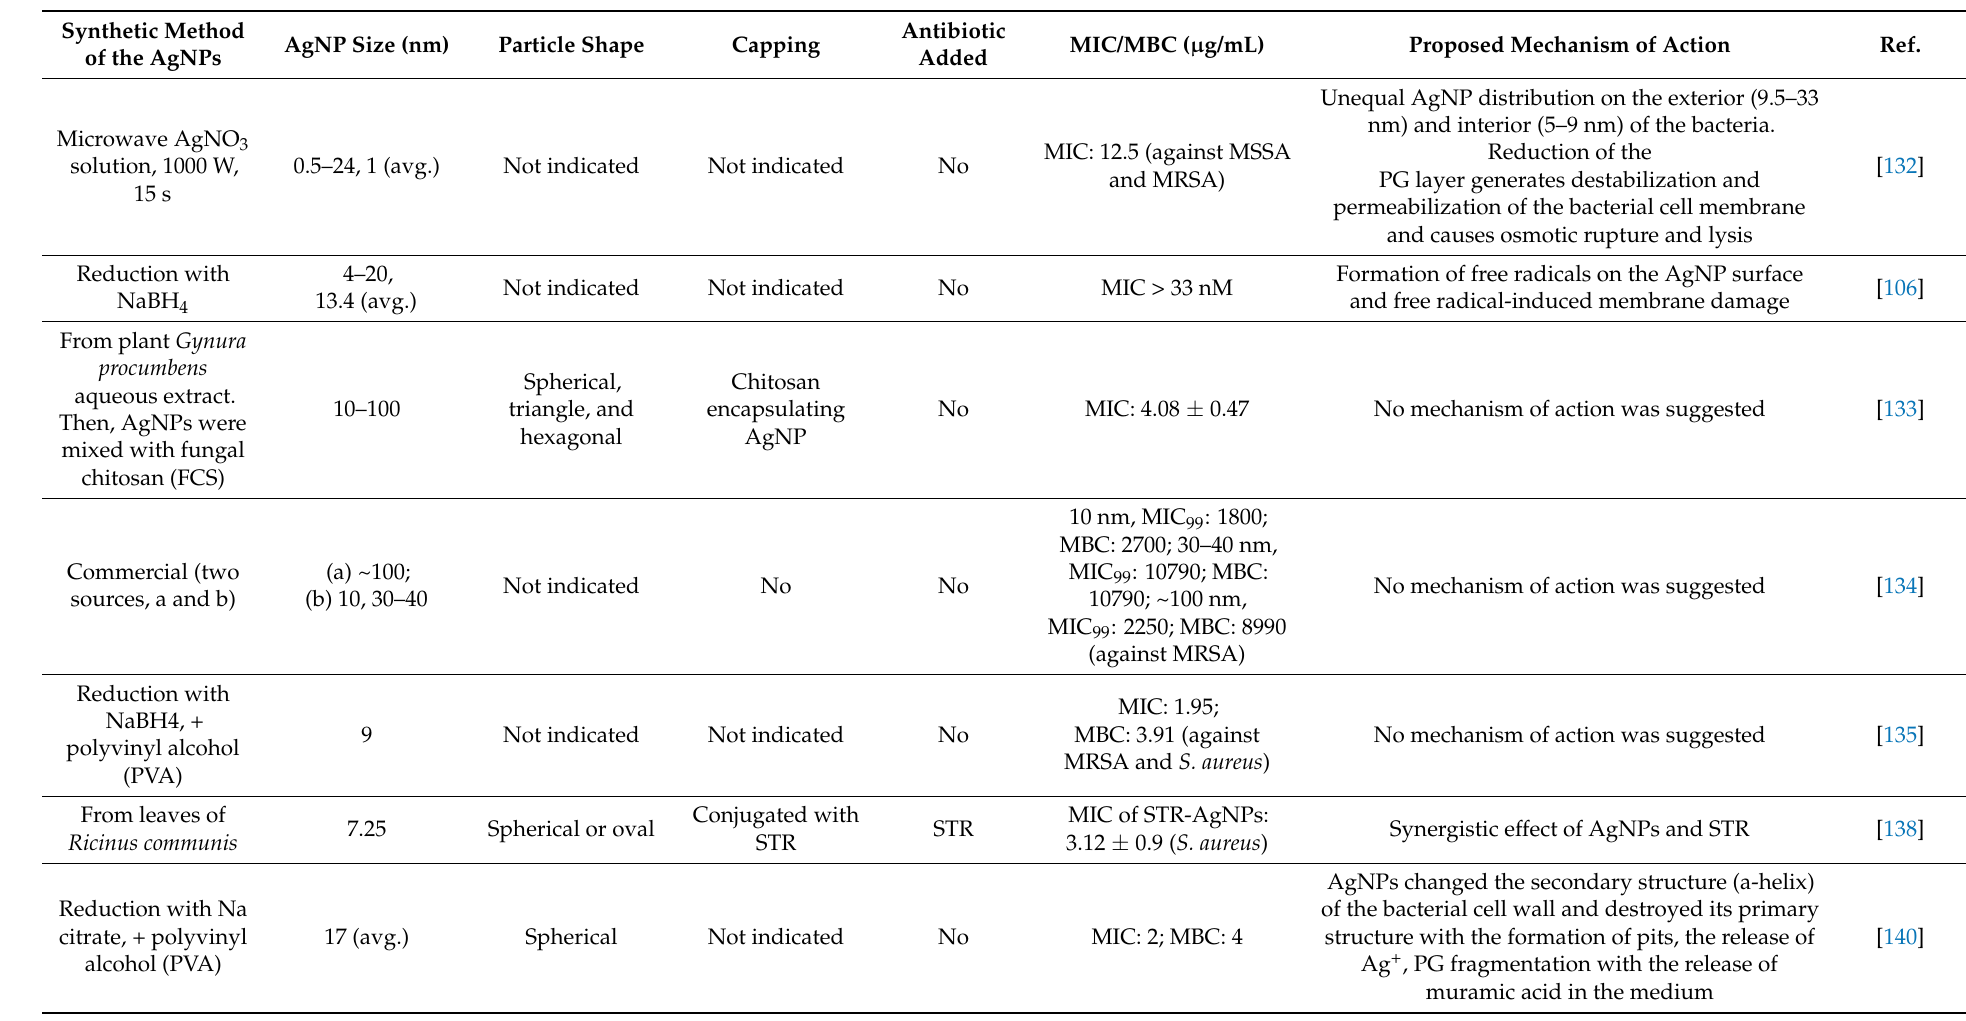
Table 4. Research on the activity of AgNPs against S. aureus in vitro